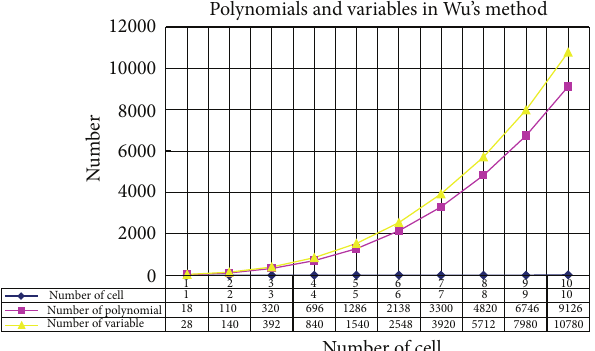
Figure 5: Polynomials and variables for safety property